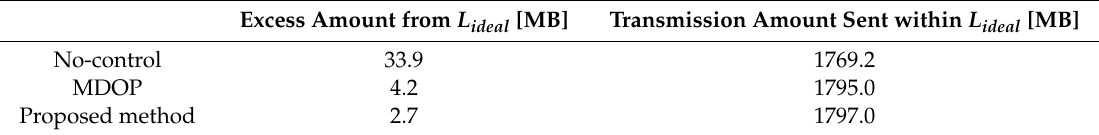
Figure 8. Learning result in performance comparison: ( a ) total reward; ( b ) average q-value. Table 6. Excess volume and transmission volume for performance comparison.